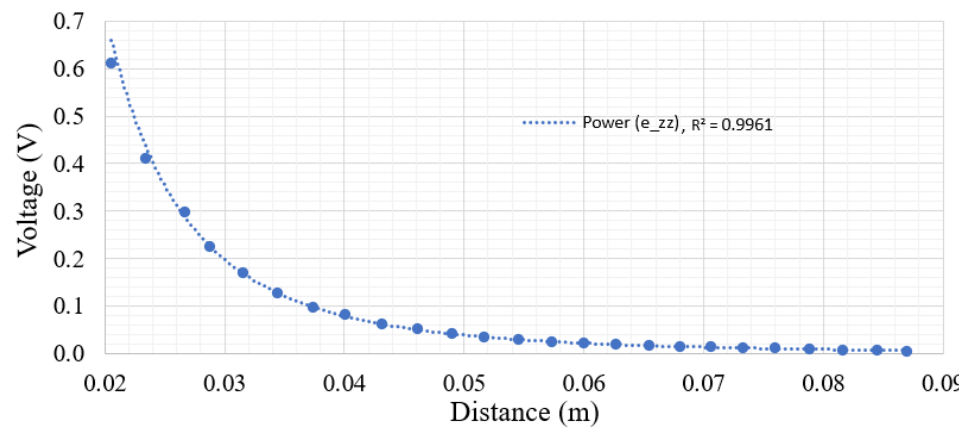
Figure 7. Influence of the distance on the position